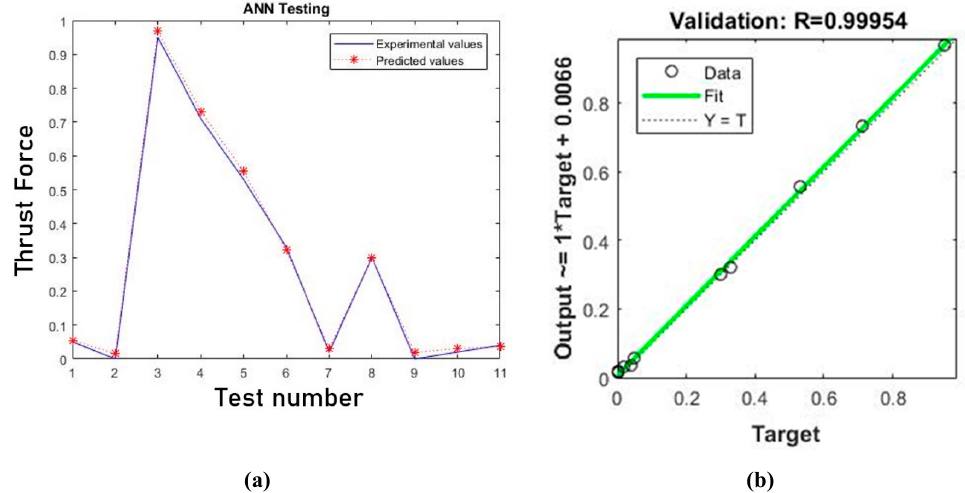
Figure 6. ( a ) Predicted and experimental values of normalized thrust force for the testing pattern and ( b ) regression analysis of the testing results.